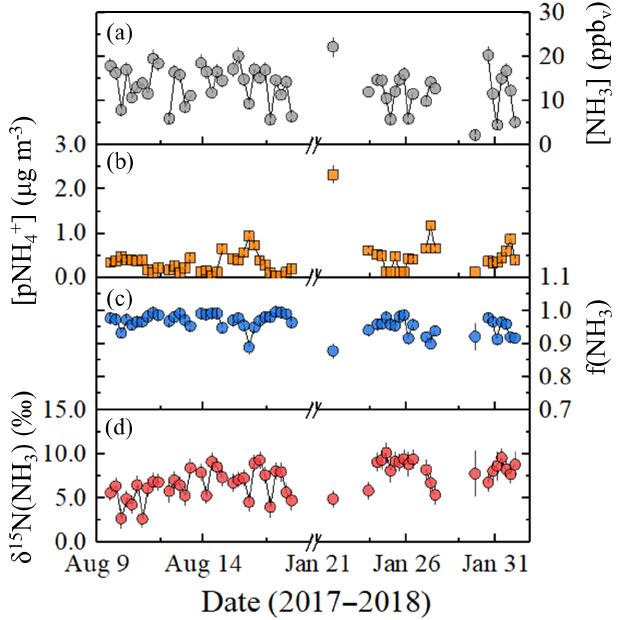
Figure 1. Near-highway (Providence, RI, USA) data summary of ] , (c) f ( NH =[ NH ] (mol) / [ NH x ] (mol)), (a) [ NH 3 ] , (b) [ pNH + 3 ) ( 3 4 and (d) δ 15 N ( NH 3 ) . The NH x data were generated from an active collection technique using a denuder-filter pack with a collection time of 6h, and the error bars for concentrations and δ 15 N ( NH 3 ) measurements shown as black vertical lines represent the RSD (%) and propagated error, respectively. The breaks in the x axes separate the summer and winter